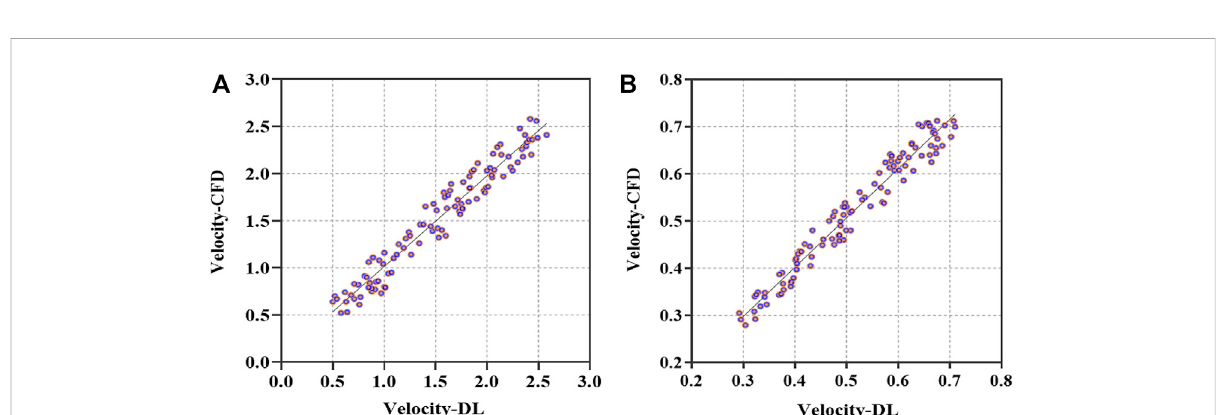
FIGURE 7 Comparison of averaged velocities in the vicinity of stenosis between DL- and CFD-based results. (A) . Scatterplot of averaged velocities for preoperativemodelsintermsofVelocity-CFD andVelocity-DL. (B) . Scatterplot ofaveraged velocities for postoperativemodelsintermsof Velocity- CFD and